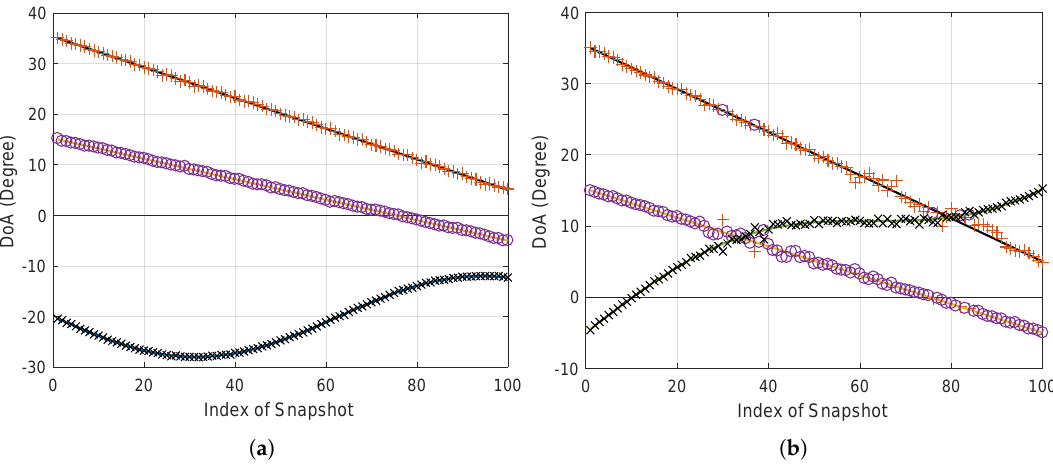
Figure 1. Tracking performance of SIC-SPICE+ with N = 20, K = 10 N, and SNR = 10 dB. The solid line and markers without line denote actual tracks of sources and estimated DoAs of SIC-SPICE+, respectively. ( a ) Case 1, ( b ) Case